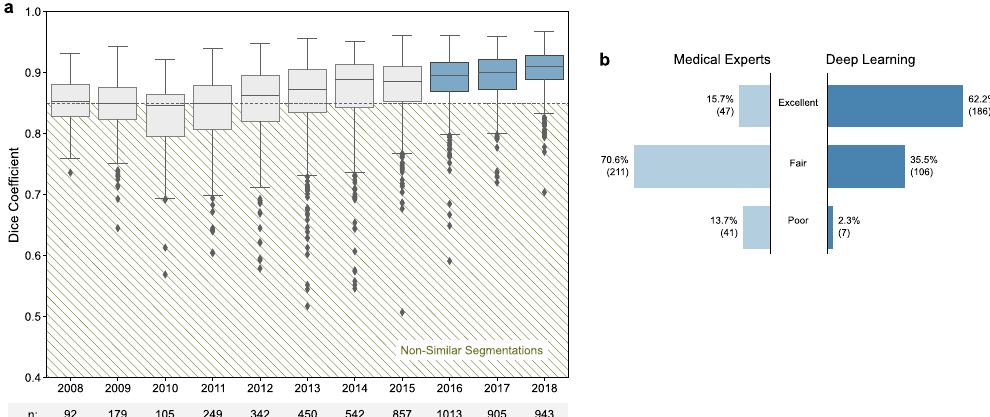
Fig. 3 Similarity of manually and automatically generated segmentations. a Dice coef fi cient between the AI framework and clinically approved heart segmentations in 5677 scans acquired between 2008 – 2018. Non-similar segmentations with a dice coef fi cient below 0.85 (dashed line) were de fi ned as failures. The boxes represent the interquartile range (IQR, 25th and 75th percentiles) and the centerlines the median of the results. The whiskers represent minimum and maximum data points, excluding outliers. Outliers are de fi ned as greater than the 75th percentile + 1.5×IQR and smaller than the 25th percentile − 1.5×IQR and are denoted as diamonds. b Results of qualitative segmentation accuracy assessment in cases de fi ned as failures between 2016 – 2018 ( n = 299) by an expert cardiovascular radiologist. The results show signi fi cantly higher segmentation accuracy for AI as compared to radiation oncology experts ( p -value <